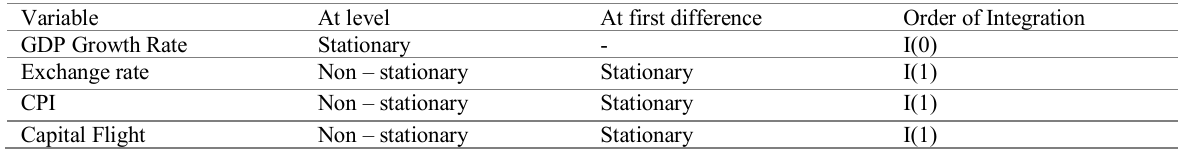
Table 4: Order of integration for